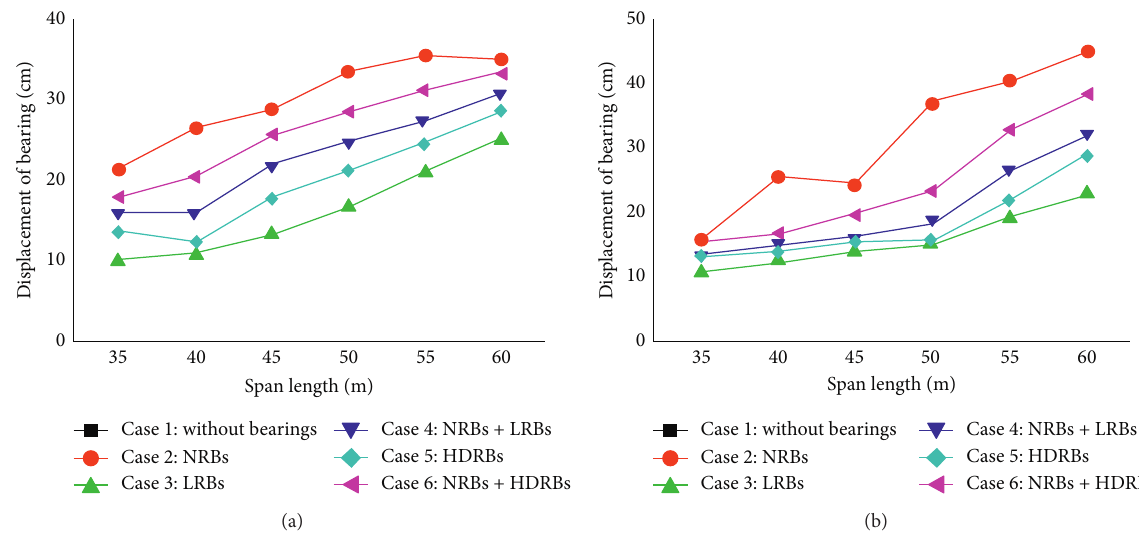
Figure 18: Displacement of bearings with the change of span length in different cases: (a) longitudinal; (b) lateral.